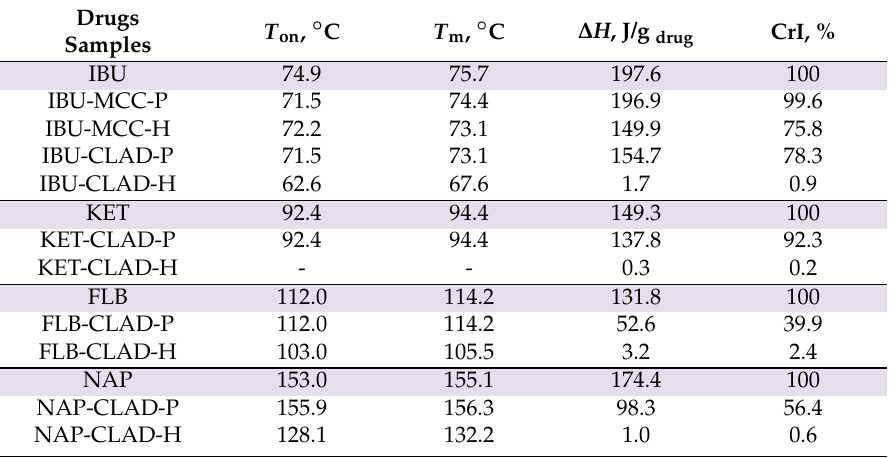
Table 3. Summary of DSC analysis of profen mixtures with